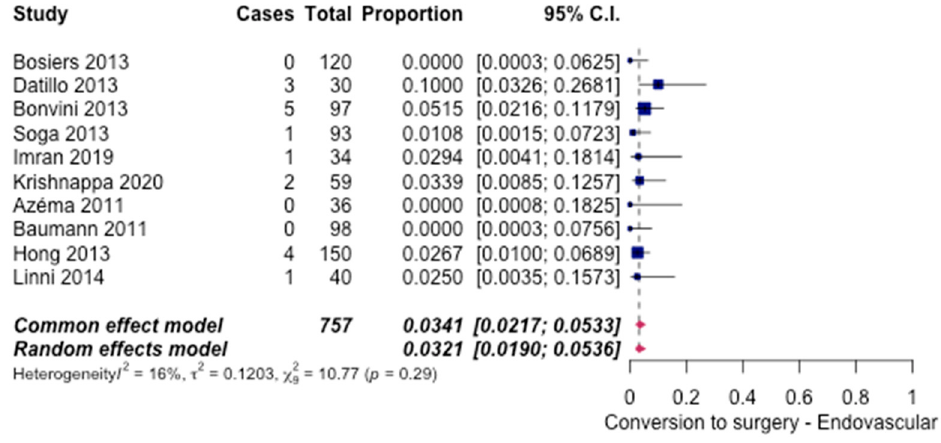
Figure 3. Forest plot for conversion to surgery in endovascular intervention [6,8,10–12,14–17,20]. Symptom improvement was reported in 9 case series [8,9,14–20] for ET procedures, while under FAE treatment, 1 RCT [6] and 5 case series [5,23–26] commented on symptom improvement. For ET procedures, the overall rate of symptom improvement was 83.10% (95% CI [73.67%, 89.63%]) (Figure 4A). However, for FAE, the overall rate was 91.64% (95% CI [84.53%, 95.66%]) (Figure 4B). An odds ratio of 0.45 (95% CI [0.30–0.67], p < 0.05) was calculated, favouring the FAE group.